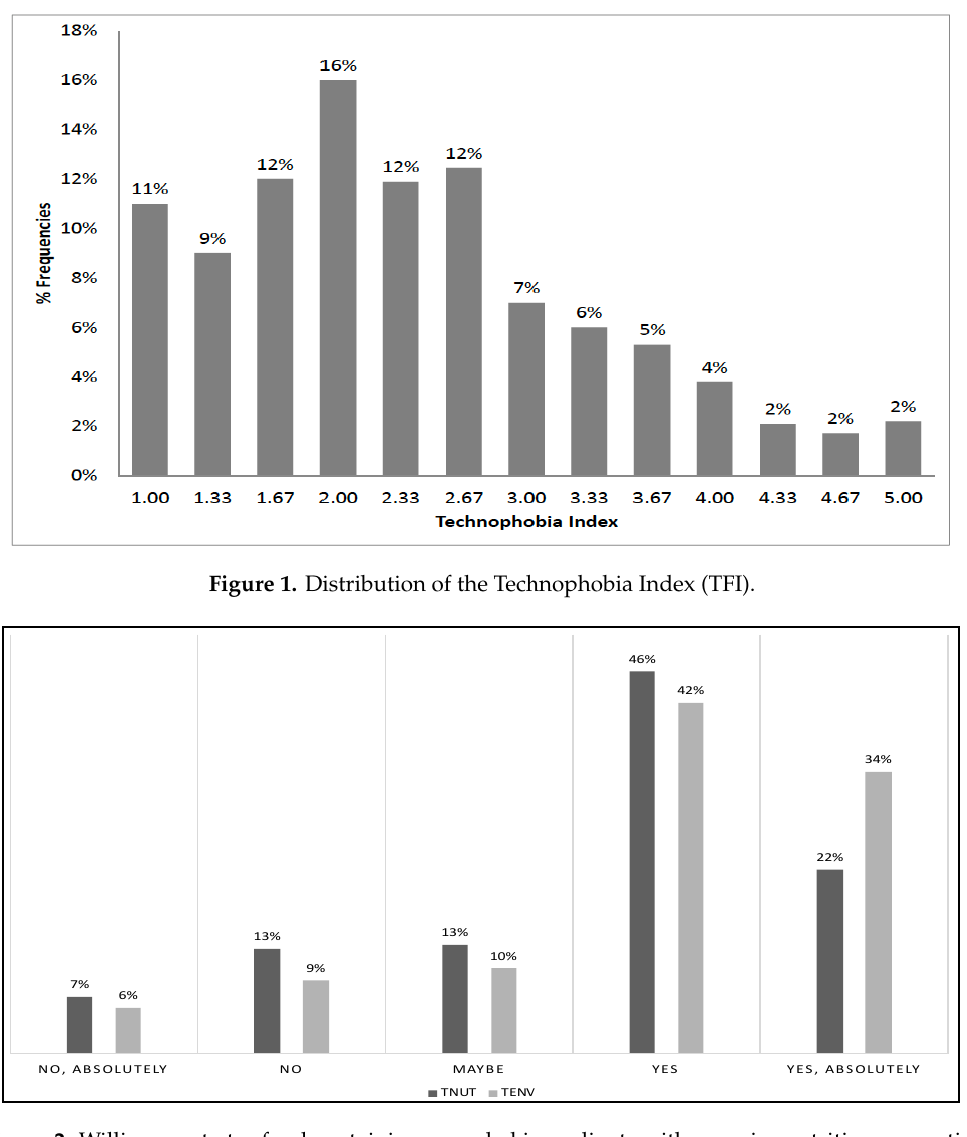
Figure 2. Willingness to try food containing upcycled ingredients with superior nutrition properties (TNUT) or lower environmental impact (TENV).